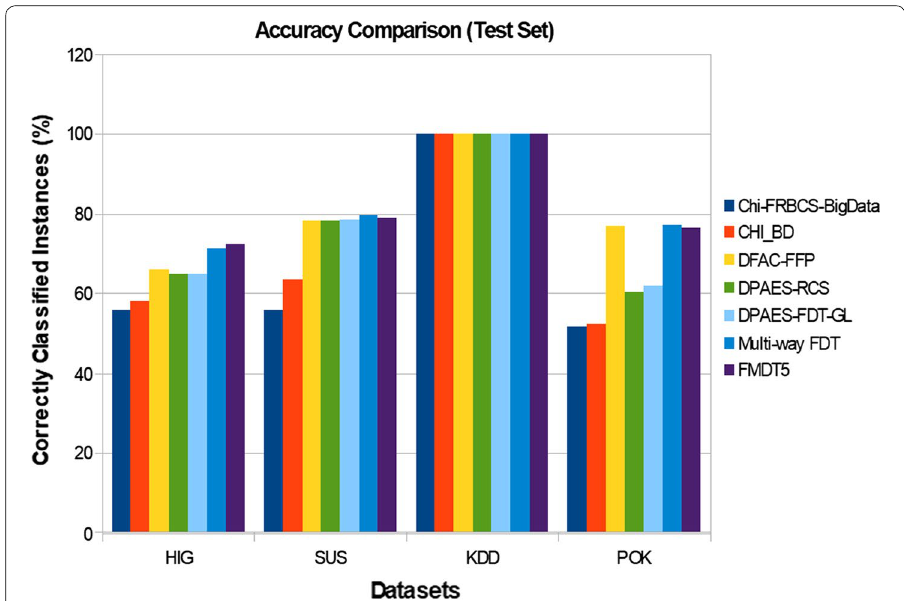
Fig. 11 Accuracy comparison among the different fuzzy classification